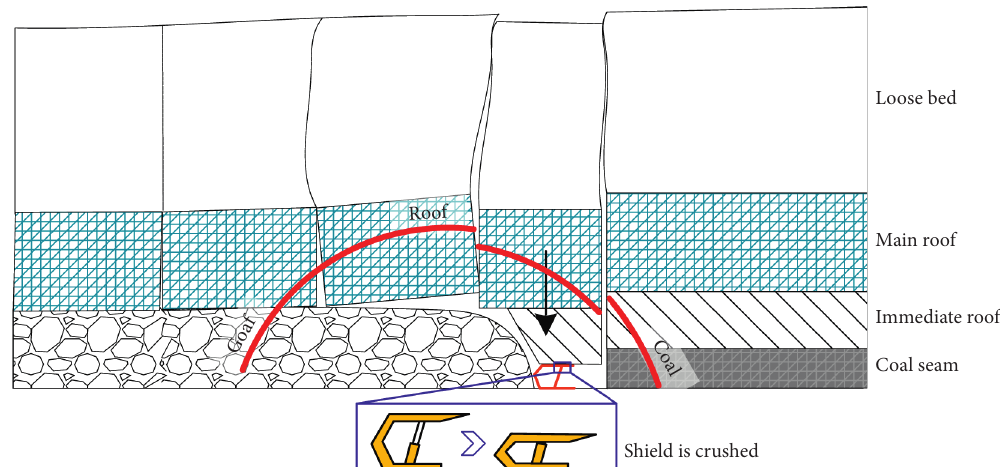
Figure 1: Complete failure of equipment removal